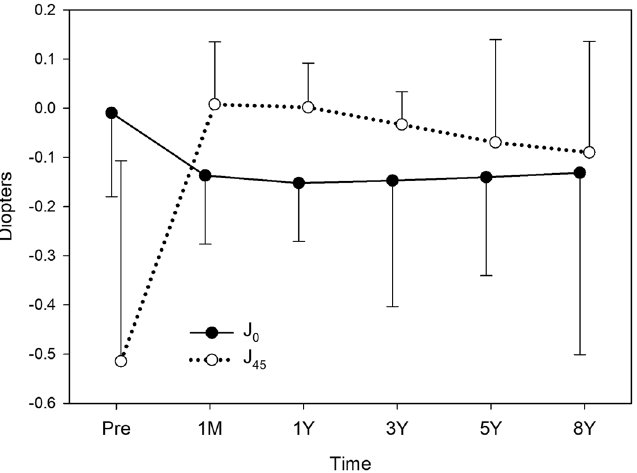
Figure 5. Time course of changes in astigmatism in eyes with preoperative oblique astigmatism. Toric IOL implantation significantly increased J 45 ( p = 0.045), but not J 45 ( p = 0.912). When postoperative values were compared, J